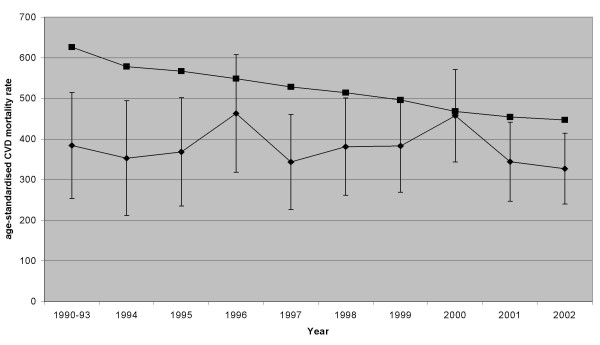
Directly age-standardised CVD mortality rates and 95 % confidence intervals for men in the cohort (◆) and men in the general German population (■). Rates are presented as per 100,000 person years/population.